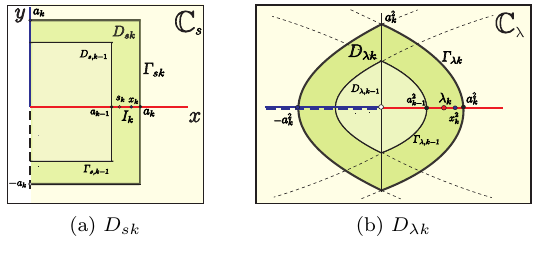
Figure 3. Domain D sk and D λk